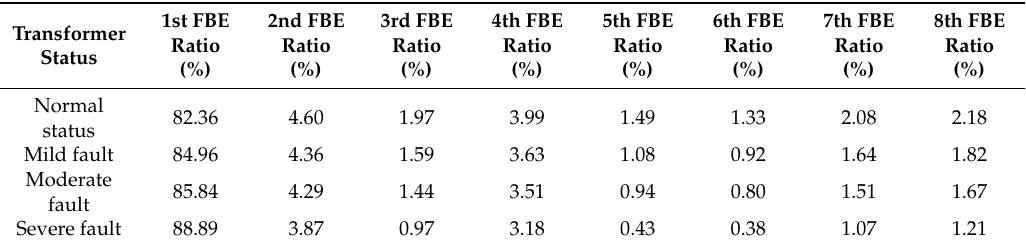
Table 1. Energy consumption ratio threshold values of each frequency band corresponding to transformer vibration signals of different fault